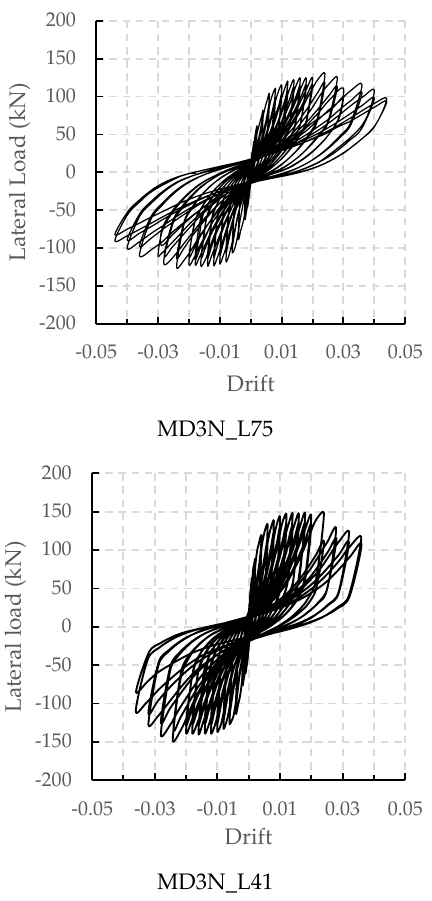
Figure 8. Lateral load – drift hysteretic curves.